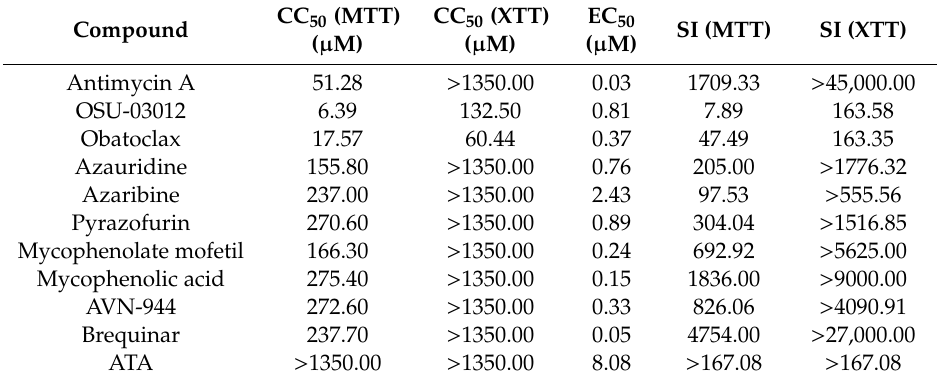
Table 4. CC 50 , EC 50 and SI of the compounds against old World ZIKV MR-766 strain. Compound